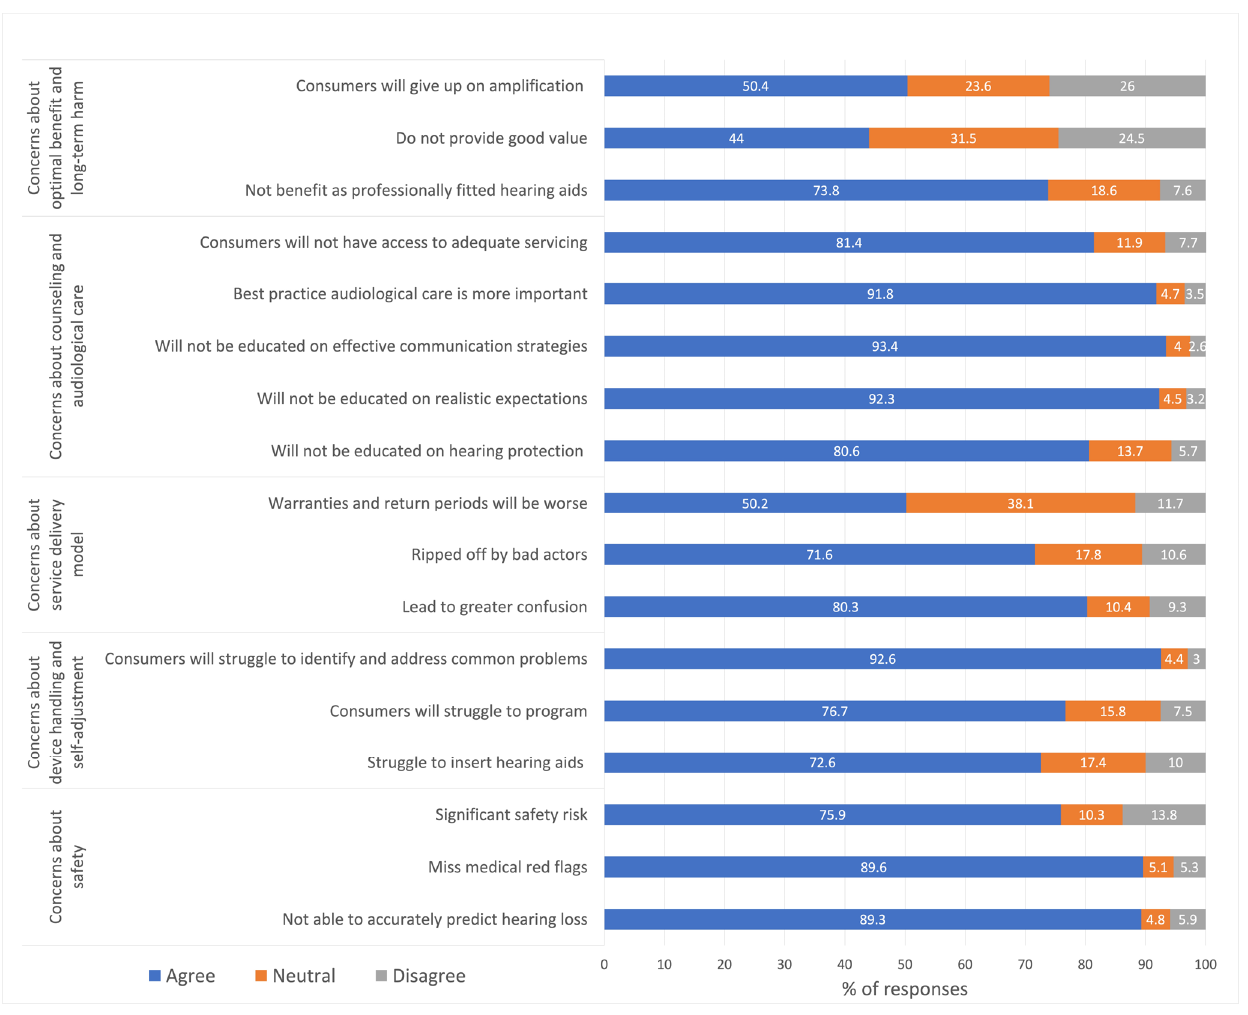
Figure 1. Hearing healthcare professionals' (HHPs) concerns towards over-the-counter (OTC) hearing aids.